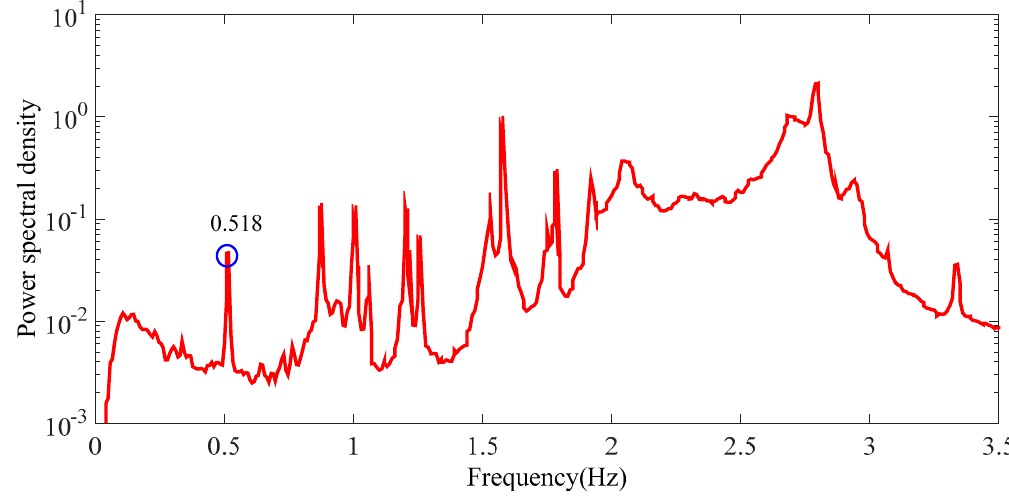
Figure 11. Average power spectral density of all vibration-monitoring points after [90].